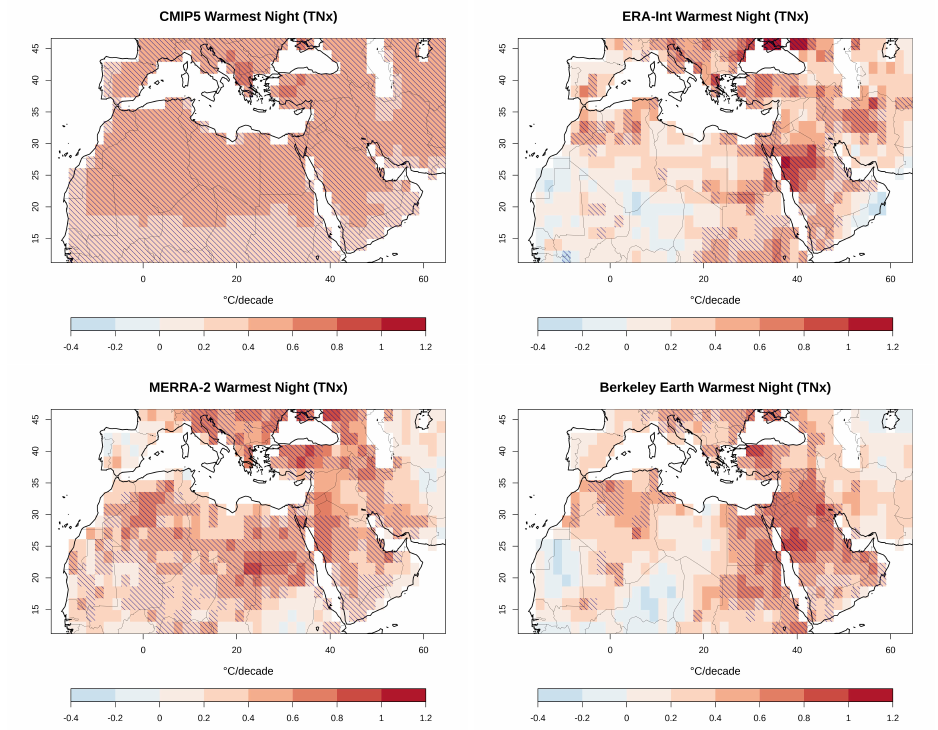
Figure 6. 1980–2018 decadal trend of the Warmest Night (TNx) for the: CMIP5 multi-model ensemble mean ( top left ), ERA-Interim ( top right ), MERRA-2 ( bottom left ), and Berkeley Earth ( bottom right